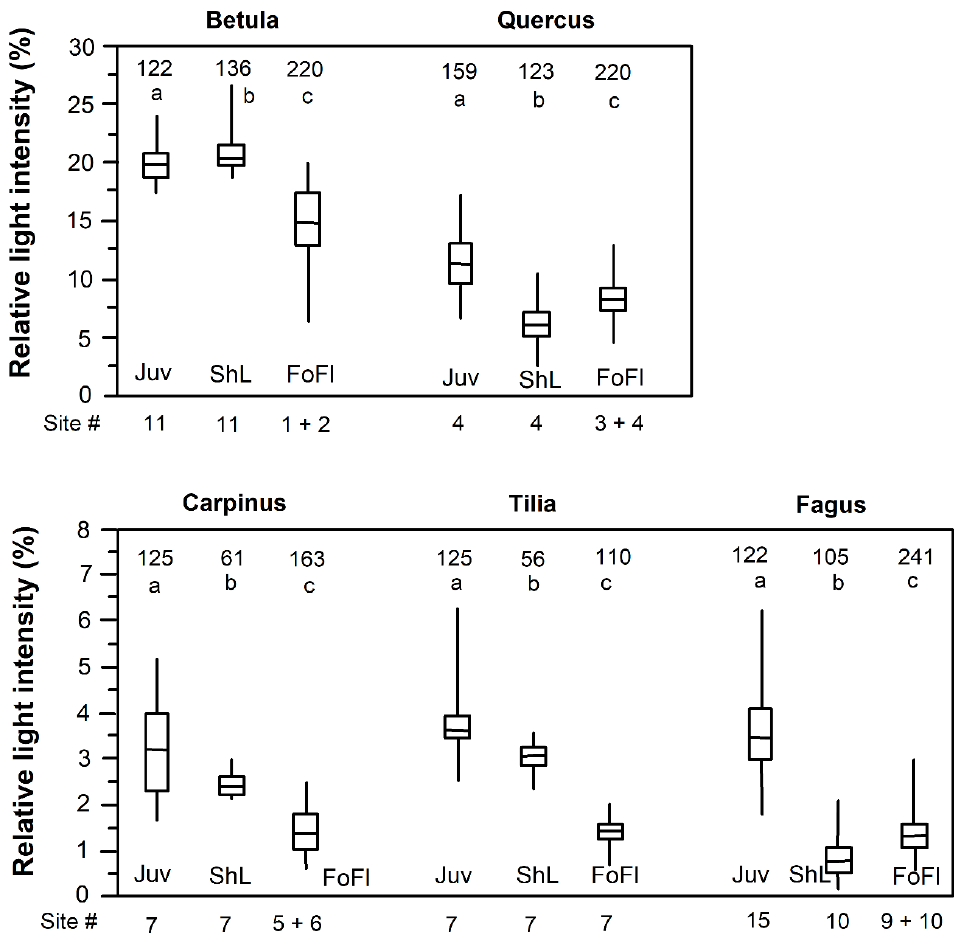
Figure 6. Relative PAR irradiance (in % of incident radiation) directly above juvenile plants (Juv), the lowermost shade leaves of adult trees (ShL), and on the forest floor (FoFl) in several stands with closed canopy of the five tree species. In order to quantify minimum light demand, the radiation measurements above vital juveniles and adult trees’ shade leaves were conducted at the